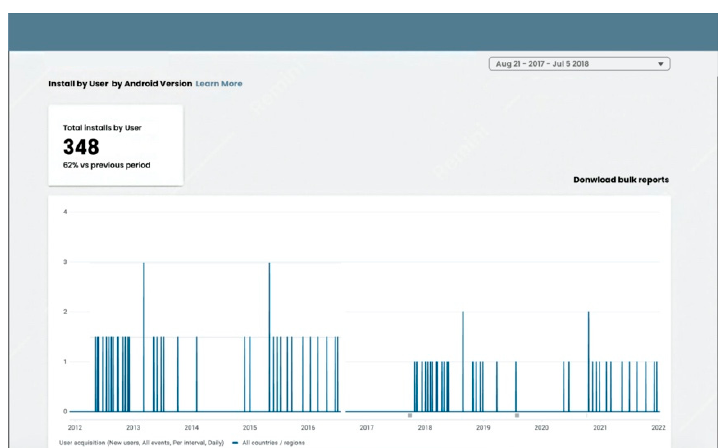
Figure 6. App downloads from account 1.